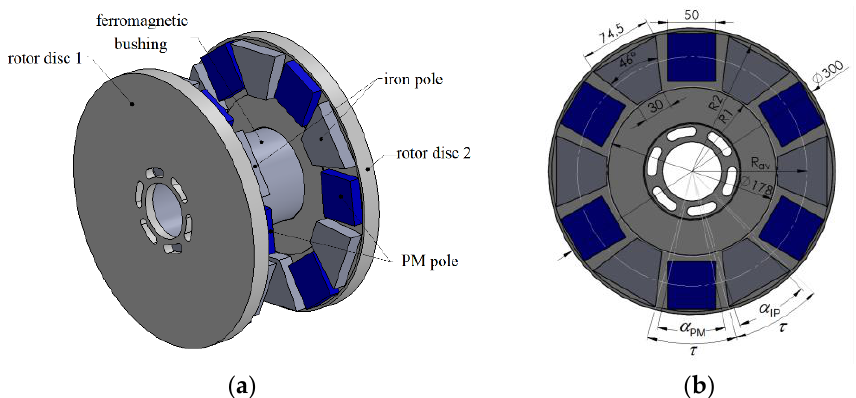
Figure 2. FCAFPMM ’s rotor ( a ), dimensions of rotor’s disc with magnets and iron poles ( b ).